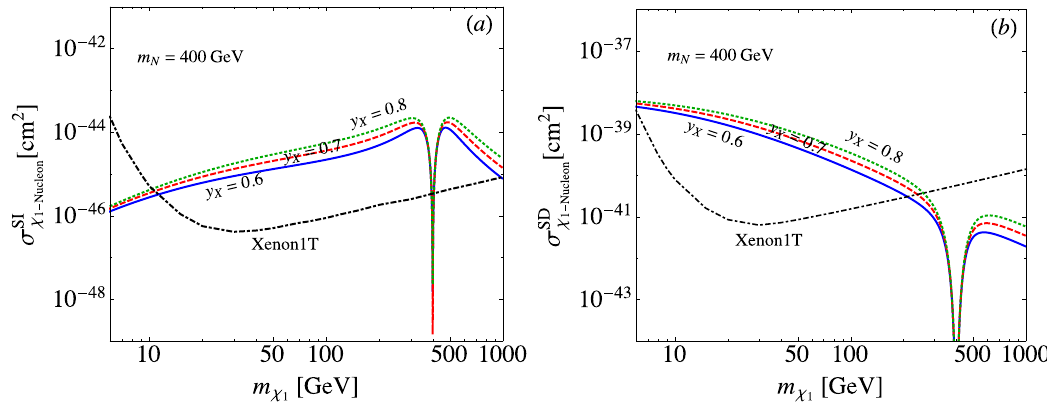
Figure 5 . (a) h -mediated spin-independent and (b) Z -mediated spin-dependent DM-nucleon scat- tering cross sections as a function of m (cid:31) , where the solid, dashed, and dotted lines denote y X = 0 : 6, 1 y X = 0 : 7, and y X = 0 : 8, respectively, and m N = 400 GeV is used. The dot-dashed lines in (a) and (b) are the Xenon1T results shown in [69,